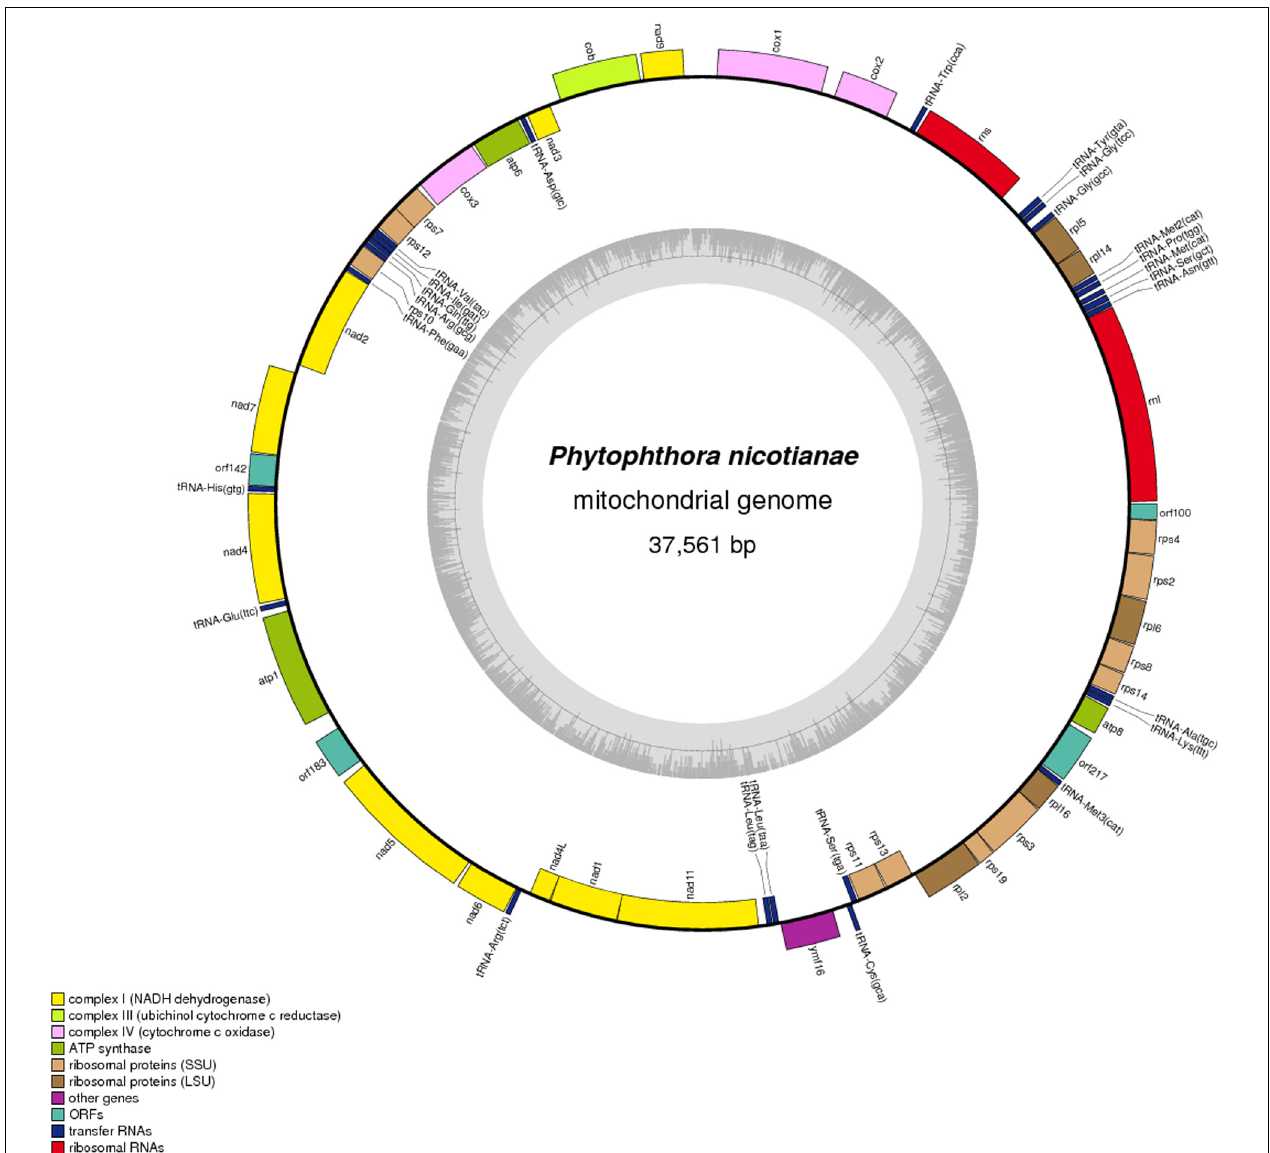
FIGURE 1 | Circular map of the mitochondrial genome of Phytophthora nicotianae. Protein coding genes, tRNA and rRNA are shown on the outer ring. Genes encoded on both strands. The inner ring shows GC